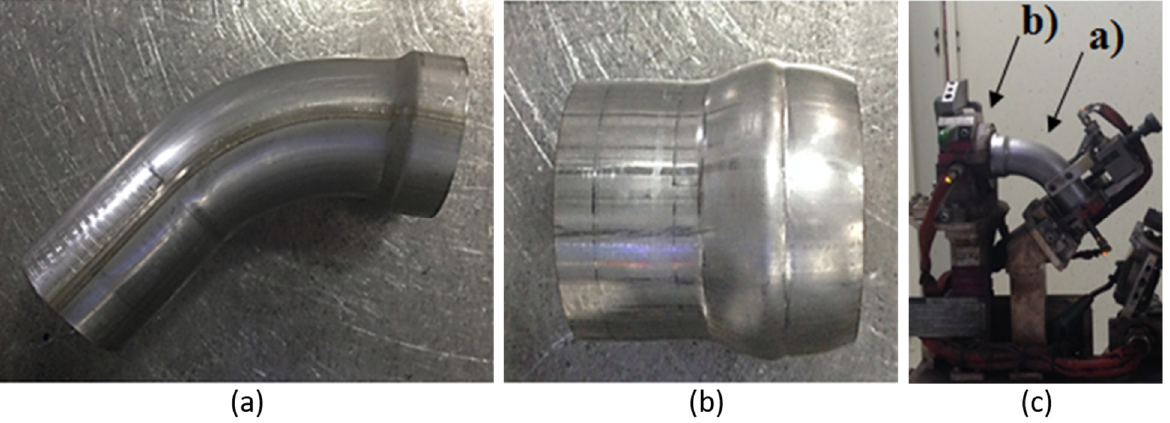
Figure 2. ( a ) Tube 63.1 mm in diameter, ( b ) tube 63.8 mm in diameter, and ( c ) welding position of the two tubes. The tubes were joined using the GMAW process, for which a welding machine SKS LSQ5 + Q8p was used together with a Fanuc Arc Mate 120iC cell, SKS PS5 Uncoiler, Collision Box Power Joint SKS, Torch SKS 61-9-120-10, and Neck SKS 58-1-45-400. The robot speed established for this work, after several experimental tests to define this parameter, was 150 cm/min because it was the highest speed where a visually stable weld bead was observed.